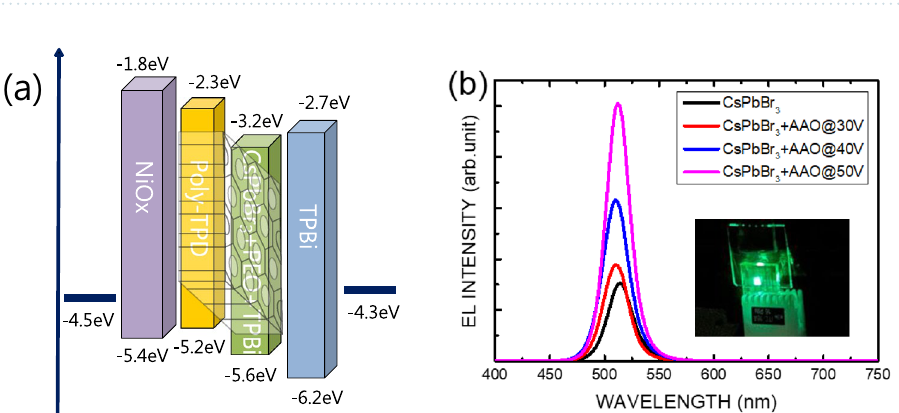
Figure 4. ( a ) Absorbance and ( b ) photoluminescence (PL) spectra of CsPbBr 3 perovskite film on and in AAO films.